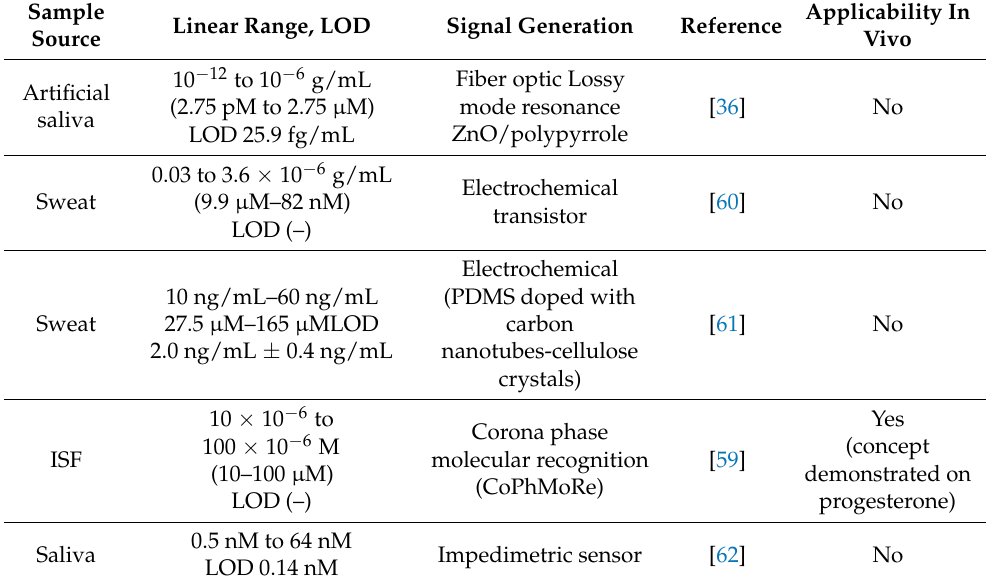
Table 3. MIP-based